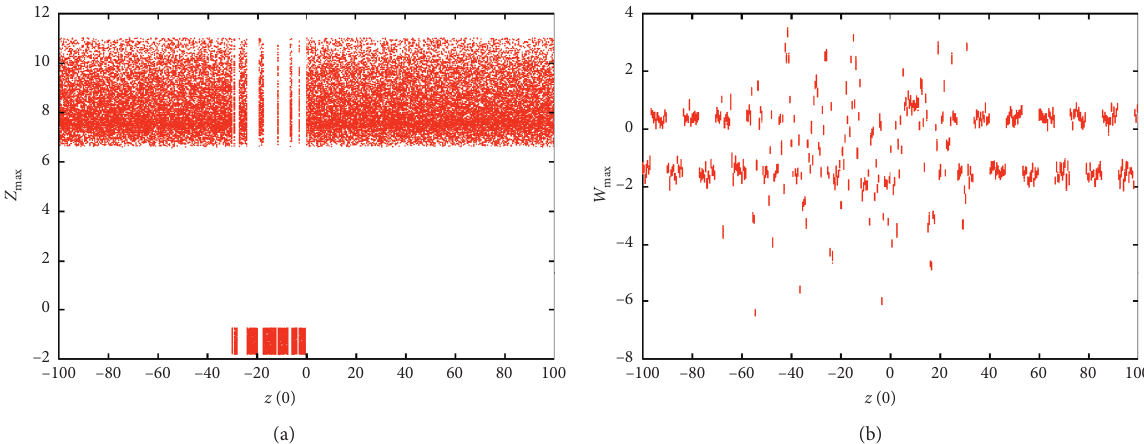
Figure 14: (a) Bifurcation diagram of the state variable z and (b) bifurcation diagram of the state variable w with respect to initial conditions (− 1 , − 1 ,z ( 0 ) , − 1 )